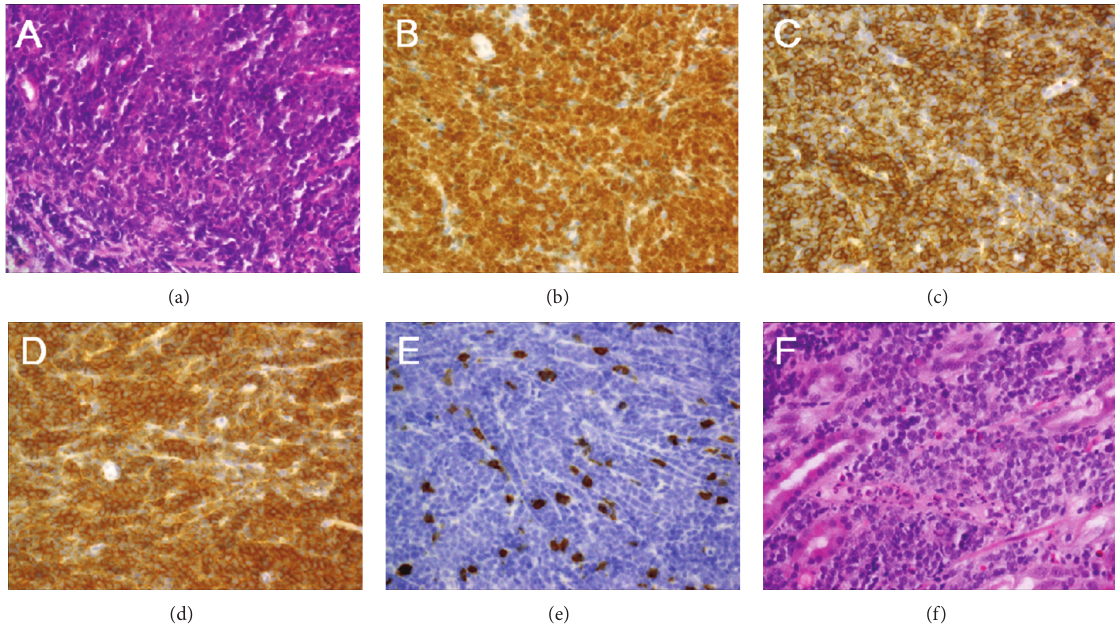
Figure 3: Histopathological images. Biopsy samples taken from the mass lesion in the temporomandibular joint revealed monotonous infiltrationofmedium-sized lymphoid cells with ahigh nuclear-cytoplasmic ratio((a)hematoxylin andeosin staining,original magnification: × 40). These cells were positive for TdT (b, × 40), CD20 (c, × 40), and CD10 (d, × 40) but negative for CD3 (e, × 40). Neoplastic lymphoma cells were also detected in the stomach (f: hematoxylin and eosin staining, ×